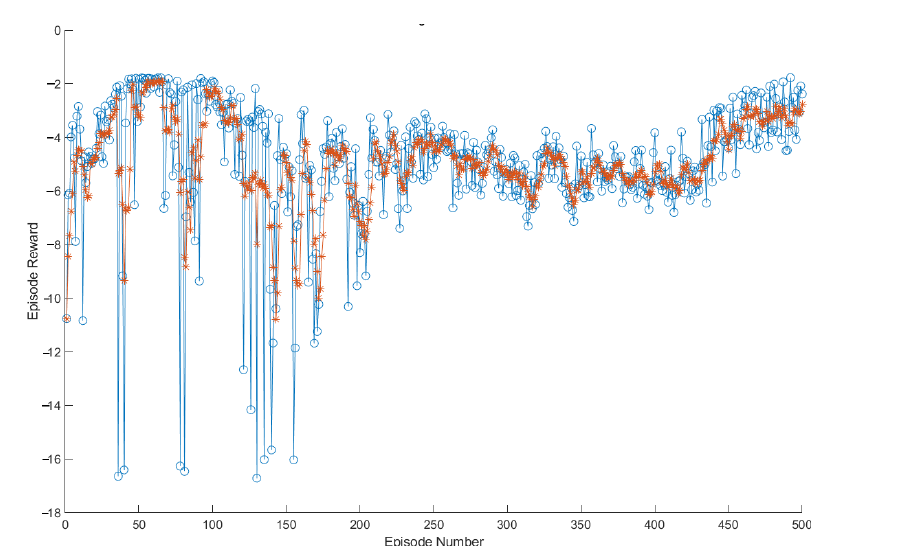
Figure 6. Illustration of the cumulative values for the extended reward (blue: actual, orange: rolling